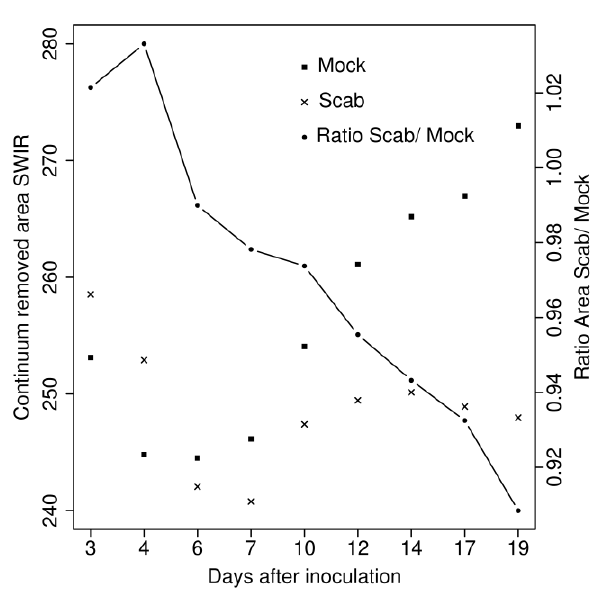
Figure 2. The average of the continuum removed SWIR areas for each measurement day for scab-inoculated (×) and control (mock) (▪) leaves. Ratio of the average areas of both treatments were plotted on the right Y-axis and represented by connected